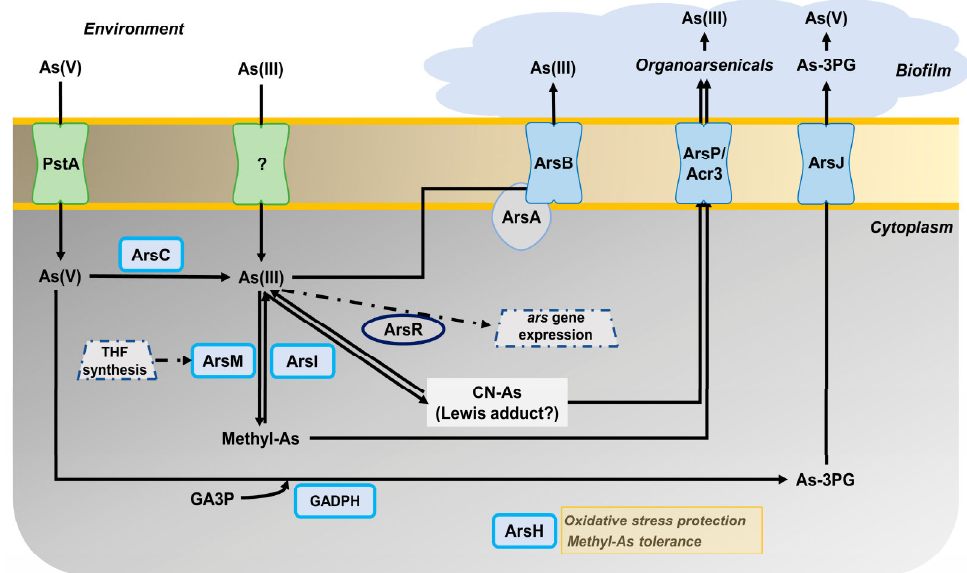
Figure 5. Overview of the arsenic metabolism in P. pseudoalcaligenes CECT 5344. The different proteins (encoded by the genes indicated in brackets) that are involved in the As tolerance of the strain CECT 5344 are: ArsC (BN5_1991; BN5_1993; BN5_2708); ArsR (BN5_1989; BN5_2707); ArsB (BN5_1992; BN5_2706); ArsA (BN5_2705); ArsI (BN5_1990); ArsH (BN5_1994; BN5_2709); glyceraldehyde-3-phosphate dehydrogenase GAPDH (BN5_2711); ArsJ (BN5_2712); ArsP (BN5_1279); Acr3 (BN5_2698); ArsM (BN5_1671; BN5_0407; BN5_4176); PstA (BN5_0117).